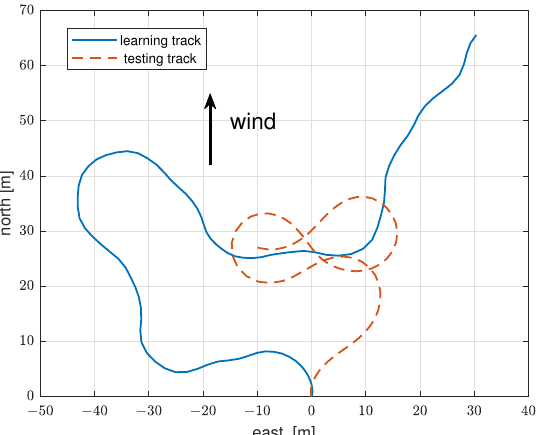
Figure 10. The navigation data used for learning the Gaussian model. The navigation sampling data of the solid blue trajectory in the figure is used as the learning data of the Gaussian model. The navigation sampling data of the orange dashed line is used as test data to verify the accuracy of the Gaussian model.